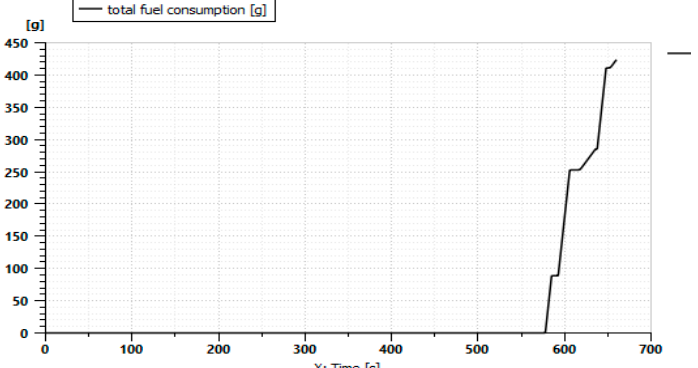
Figure 27. Fuel consumption.